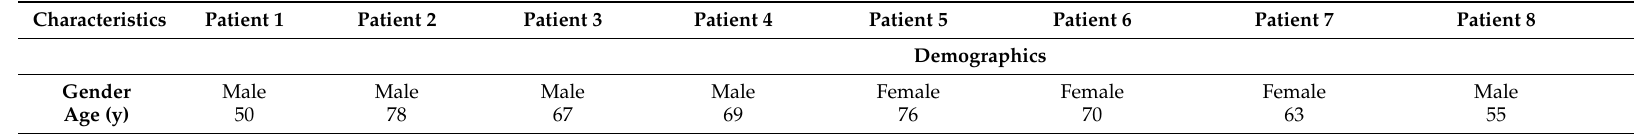
Table 1. Clinical characteristics of CAPA